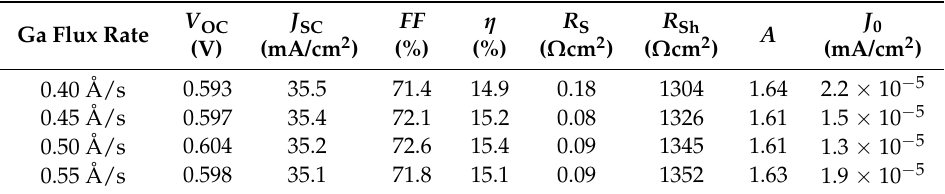
Table 2. Performance parameters of CIGS solar cells prepared by the three-stage process with various Ga flux rates during the third